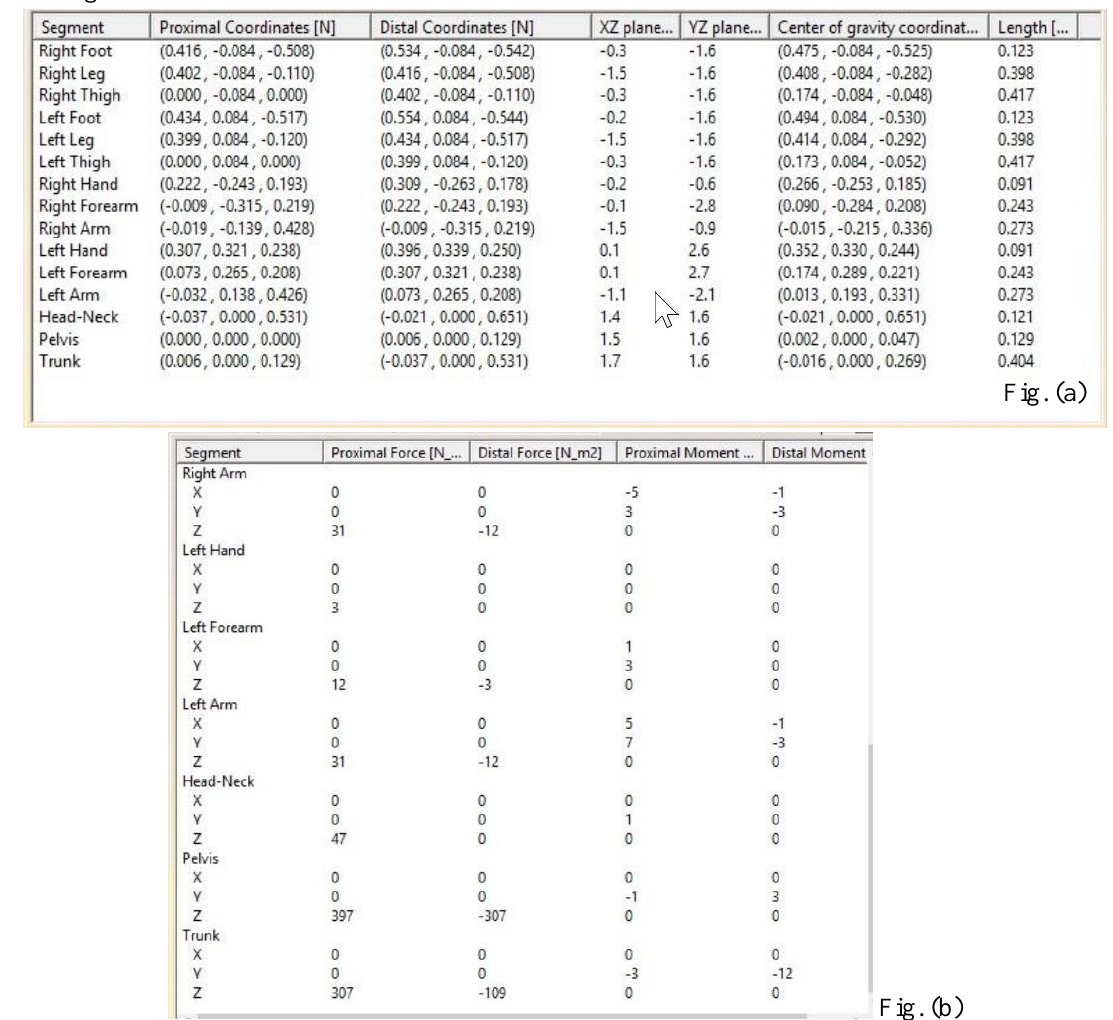
Figure 6. Biomechanical analysis of the improved body position: (a) Segment positions; (b) Reaction